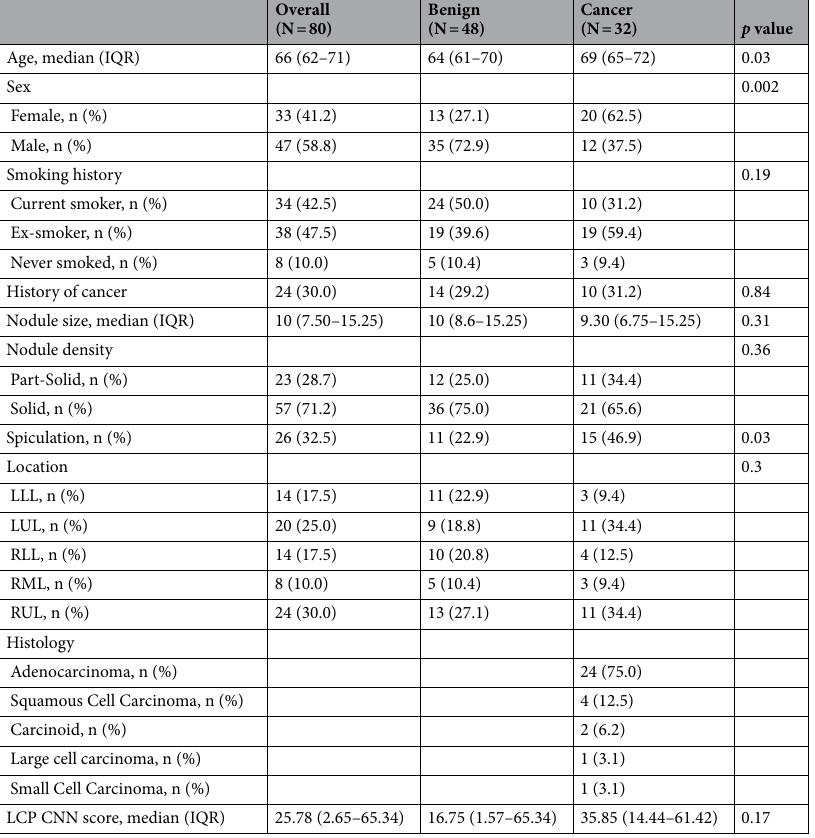
Table 1. Baseline characteristics of study participants. IQR Interquartile range; LLL Left lower lobe; LUL Left upper lobe; RLL Right lower lobe; RML Right middle lobe; RUL Right upper lobe.